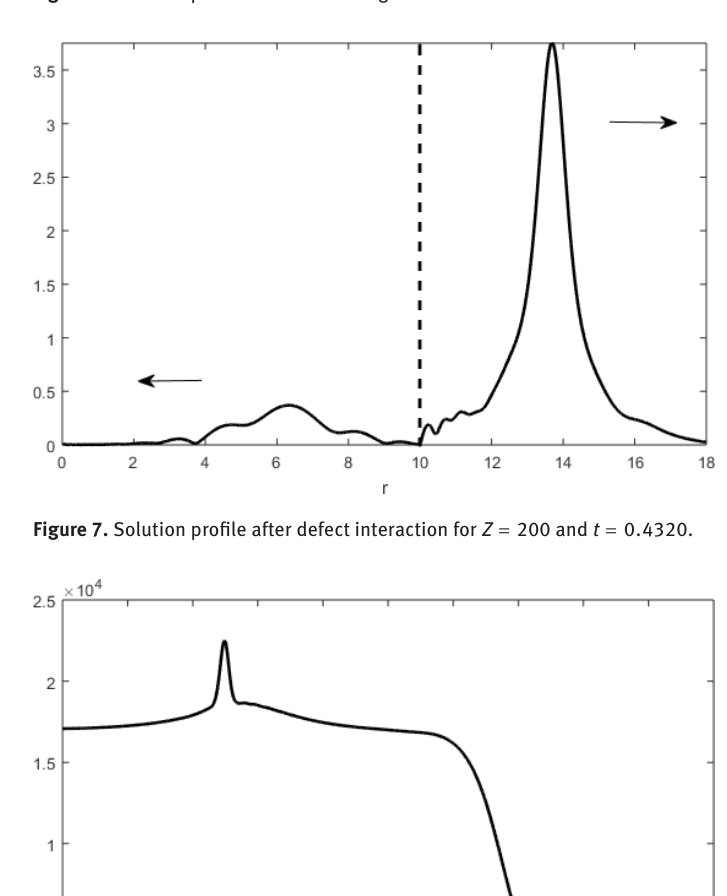
Figure 8. Variation of ‖ v r ‖ 2